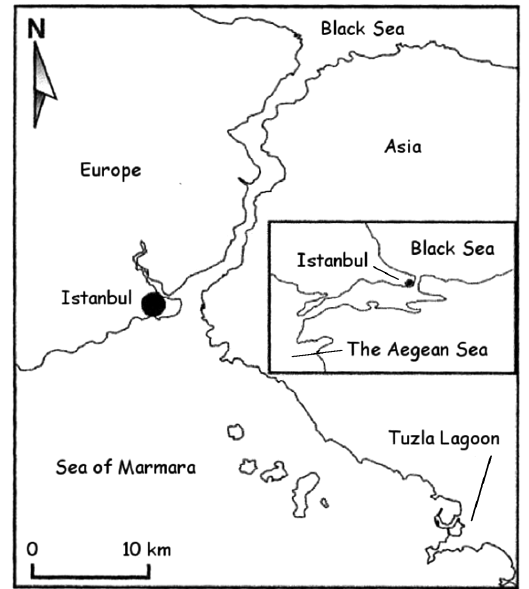
Figure 1. The location map of the Tuzla Kamil Abdus Lagoon. Redrawn from Ozturk